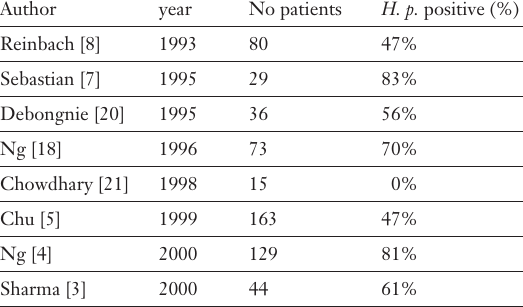
Prevalence of Heli- cobacter pylori infec- tion in patients with perforated peptic